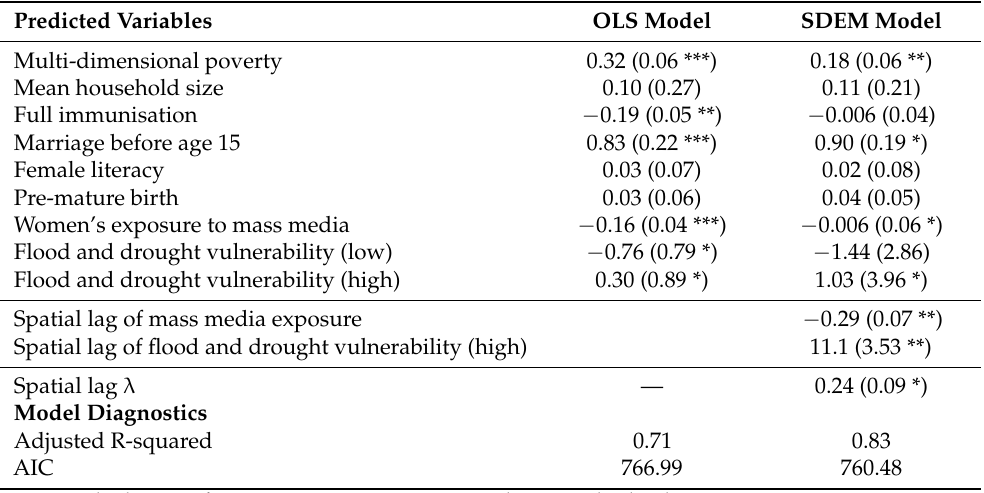
Table 2. Estimated results from ordinary least squares (OLS) and spatial Durbin error model (SDEM). Predicted Variables OLS Model SDEM Model Multi-dimensional